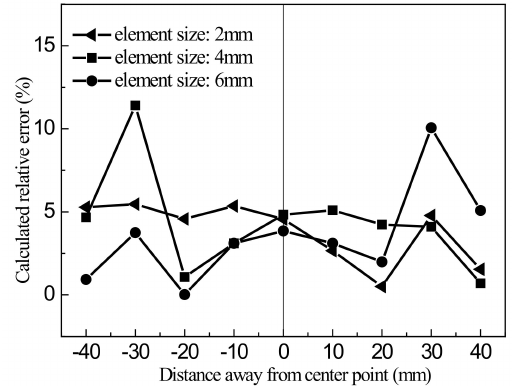
Figure 19. Relative error in the simulation results using the S8R quadratic